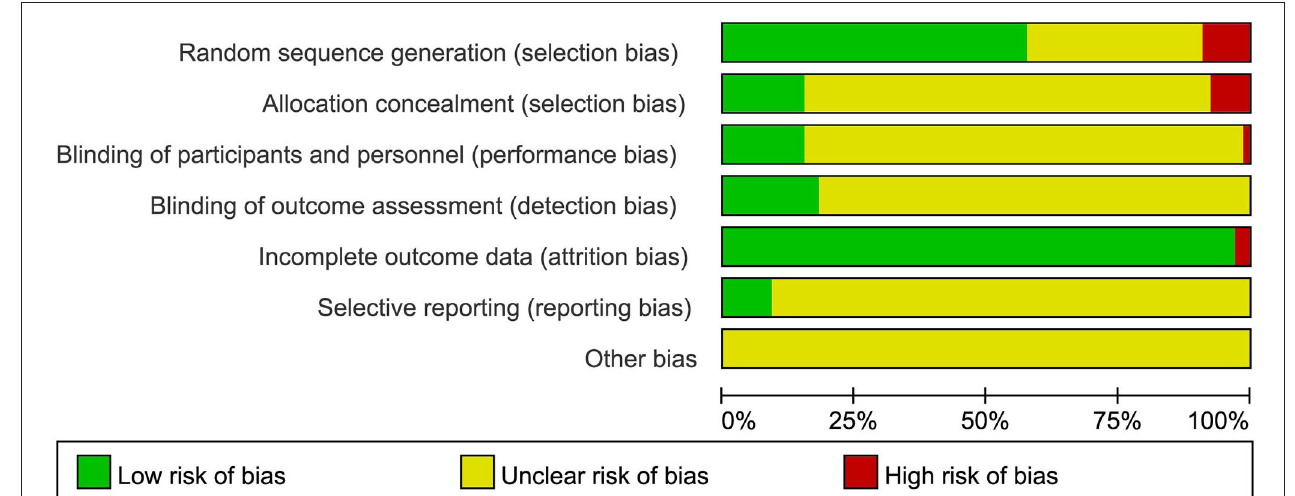
FIGURE 2 | Demonstrate the risk of bias in the included